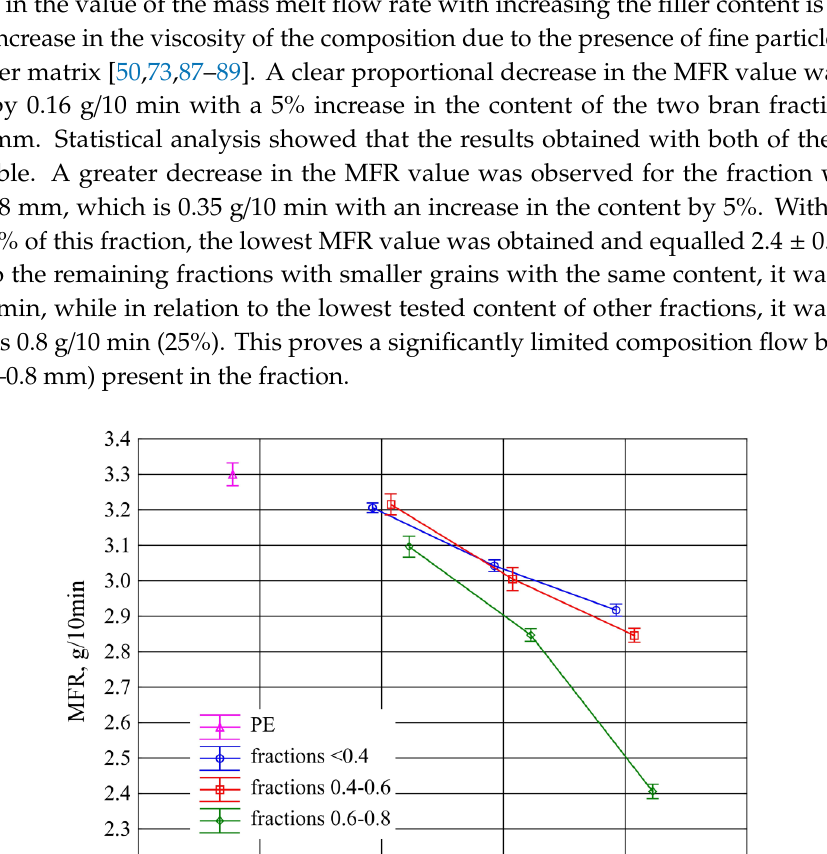
Figure 12. Appearance of the unfilled polyethylene moulding at measuring point A (the position of the point is marked in Figure 1).